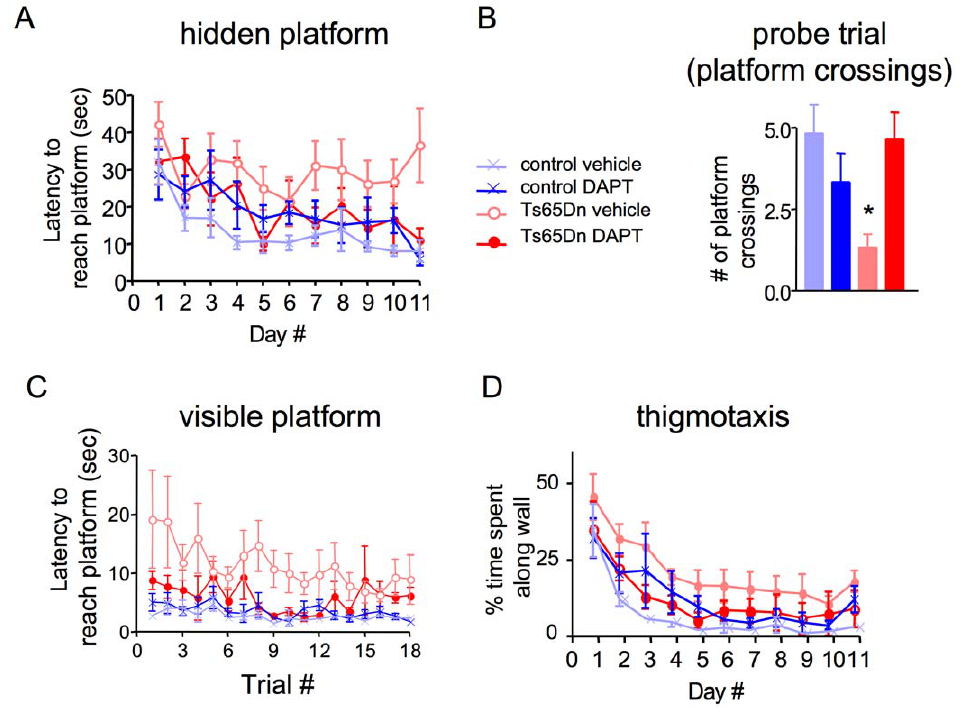
Figure 2. DAPT reverses cognitive deficits in 4-month-old Ts65Dn mice in the Morris water maze. DAPT was administered to Ts65Dn and control mice (100 mg/kg/day) two days prior to, and throughout, the maze testing. (A) Hidden platform test, latency to reach platform during training. (B) Probe trial on day 12, number of platform crossings. (C) Visible platform test, latency to reach platform. (D) Thigmotaxis. Statistical Analysis: n=6 for all groups (A–D). (A) 2-way ANOVA with repeated measures revealed a main effect of genotype F1,20=11.31, p=0.003 & Day F10,200=4.90, p=3.00E-06 and an interaction between genotype and DAPT F1,20=7.73, p=0.012. Post-hoc planned comparison test between Ts65Dn + vehicle and all 3 other groups (Ts65Dn + vehicle vs. Ts65Dn + DAPT p=0.02, Ts65Dn + vehicle vs. control + vehicle p=0.0003, Ts65Dn + vehicle vs. control + DAPT p=0.008, n=6 in all groups for all figures). (B) 2-way ANOVA for number of target platform crossings revealed an interaction between genotype and DAPT F1,20=8.46, p=0.009. Post-hoc planned comparison test revealed a significant difference between Ts65Dn + vehicle vs. Ts65Dn + DAPT p=0.01 and between Ts65Dn + vehicle vs. control + vehicle p=0.007. No significant differences were observed for number of crossings of the analogous, virtual opposite platform location (not shown). (C) 2-way ANOVA with repeated measures revealed significant effects of genotype, F1,20=9.91, p=0.005 and day, F10,200=21.42, p=0.001, as well as a significant interaction between genotype and DAPT, F1,20=5.43, p=0.03. Post- hoc planned comparison test revealed significant differences between Ts65Dn + vehicle vs. all 3 other groups (vs. Ts65Dn + DAPT p=0.04, vs. control + vehicle p=0.003, and vs. control + DAPT p=0.005). (D) 2-way ANOVA with repeated measures revealed main effects of genotype, F1,20=5.13, p=0.03 & day F10,200=21.94, p , 1.00E-06 with an interaction between genotype and DAPT, F1,20=5.43, p=0.03. Post-hoc planned comparison test revealed only a significant difference between Ts65Dn + vehicle vs. control + vehicle p=0.004.